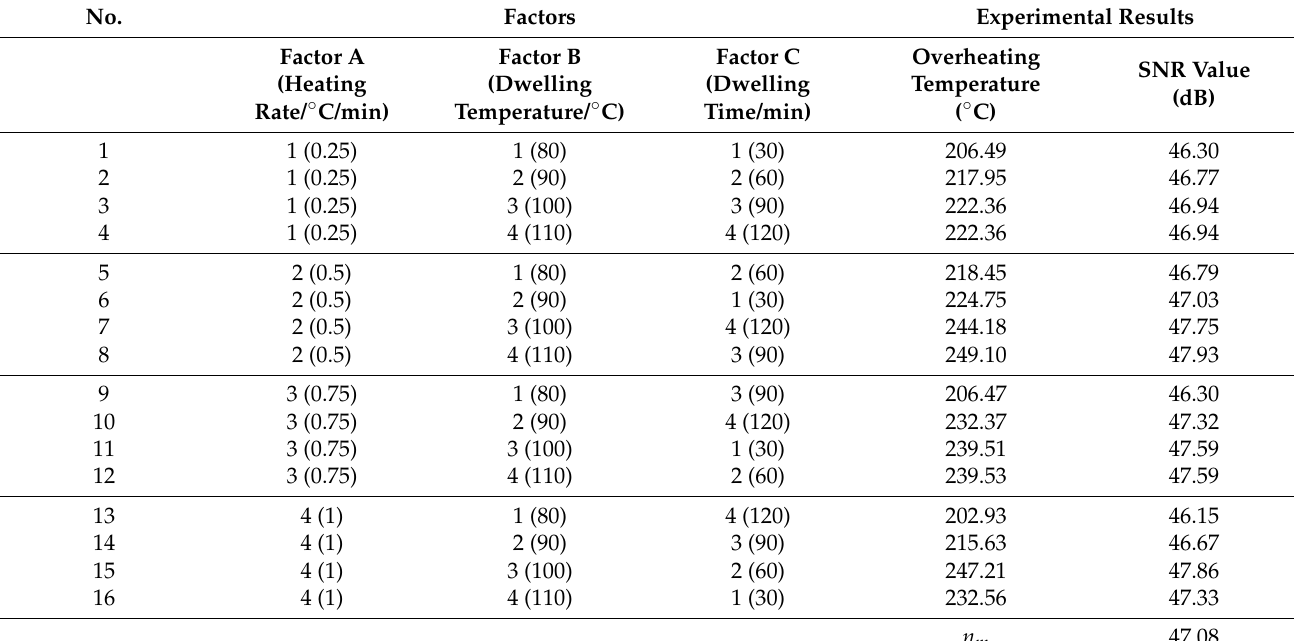
Table 3. Level combinations and experimental values.